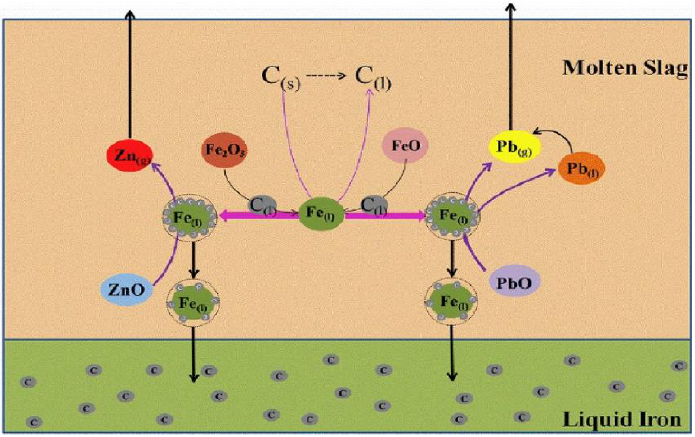
Figure 10. Reduction mechanism of Zn and Pb during Fe oxide reduction [34]